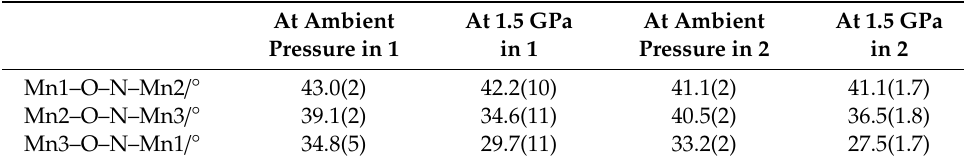
Table 1. Comparison of the Mn–O–N–Mn torsion angles ( ◦ ) at ambient pressure and at 1.5 GPa for complexes 1 and 2 .